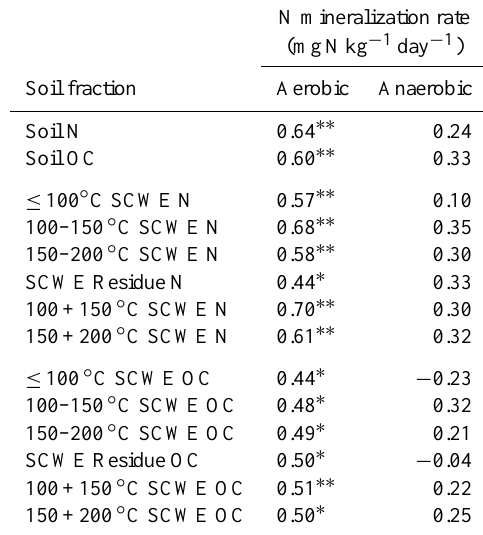
Table 4. Pearson’s correlation coefficients between amounts (gkg − 1 ) of SCWE N and OC and the rate of soil N mineralization, measured under aerobic and anaerobic